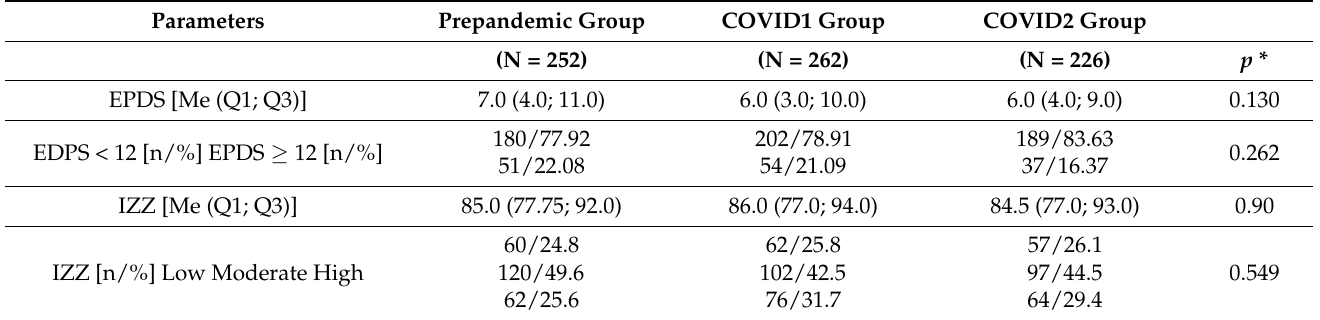
Table 2. The level of depressive disorders and health behaviors in women.